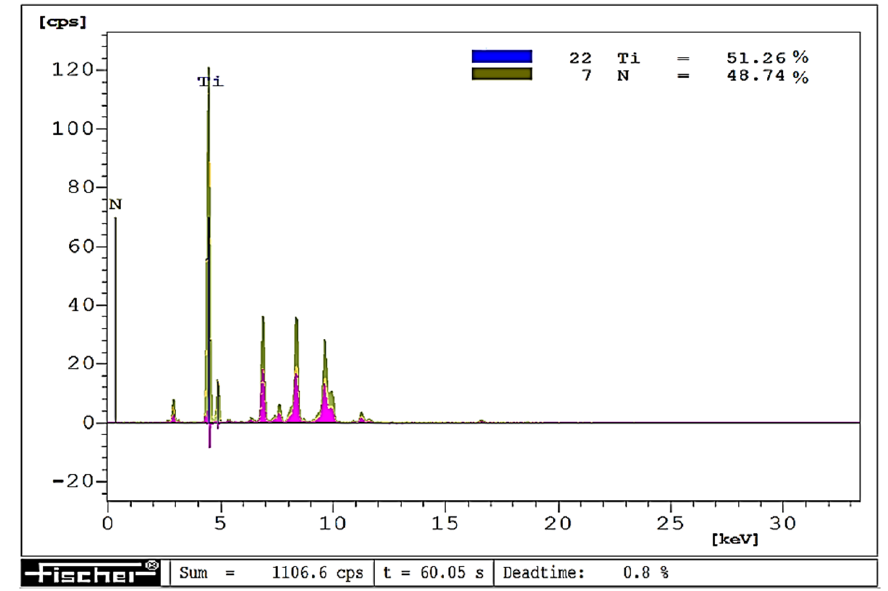
Figure 17. EDXRF image of a TiN coating after laser heating with 40% of maximum laser power.